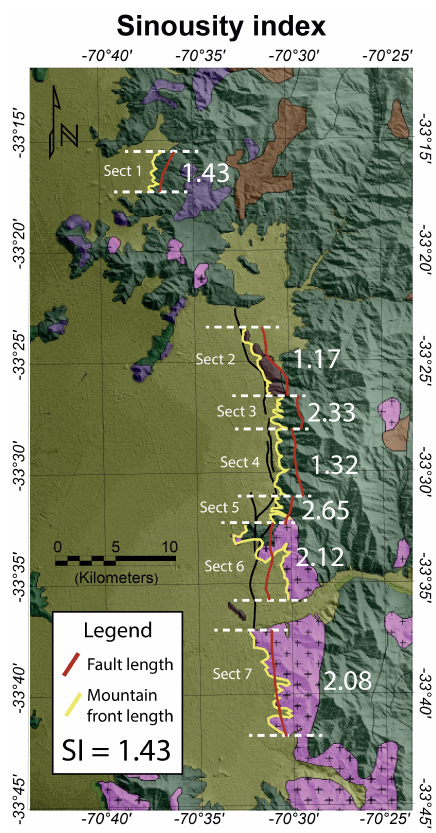
Figure 8. Sinuosity index results. In white the SI values associated with a specific part of the fault named as a section (Sect) in this figure are shown. It is important to note that these sections do not necessarily represent the segments of the fault, they are just a dis- crete separation along the SRF related to changes in sinuosity in the mountain front. As a reference, the geological map of the zone (Fig. 1) is included in the